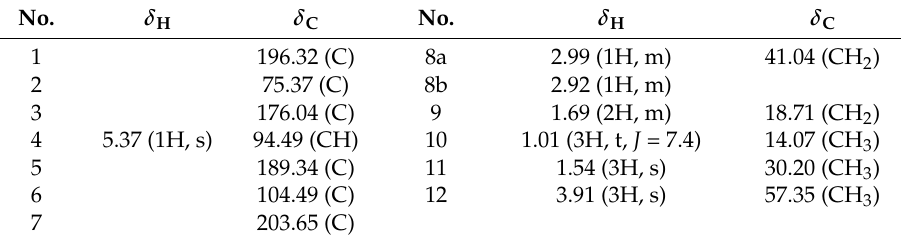
Figure 3. Key HMBC correlations of 1 and 2 . Therefore, the structure of 1 was concluded to be a new acylphloroglucinol, 6-isobutyryl-2,5- dihydroxy-2-methyl-3-methoxy-cyclohexa-3,5-dien-1-one, and was named dryofragone. Compound 2 was obtained as a mixture with compound 3 initially. The 13 C-NMR spectrum of the mixture revealed 28 resonance signals (Figure S12) in which half were consistent with the data